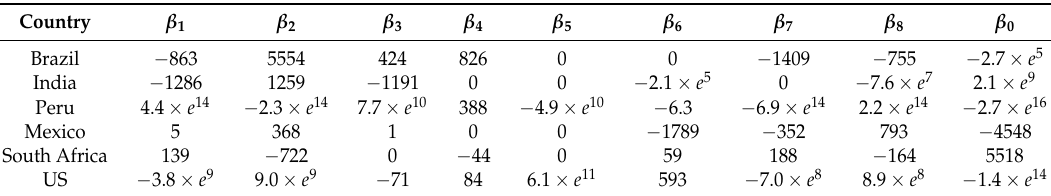
Table 3. Multiple Linear Regression Models of Some Countries.